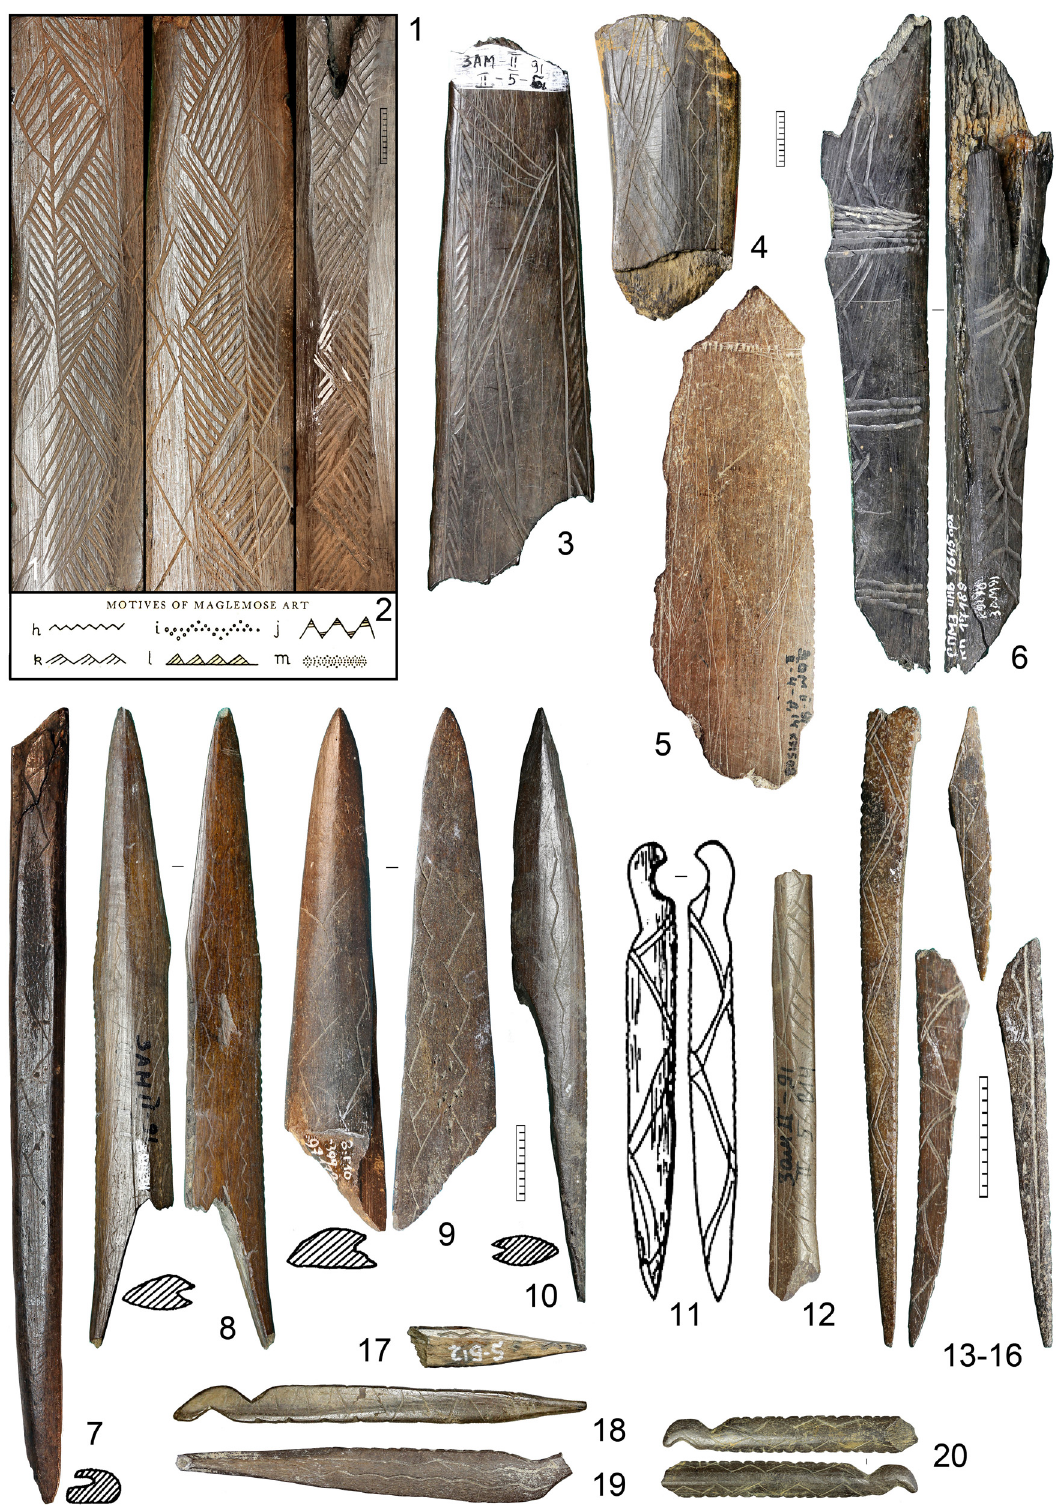
Figure 4: Zamostje 2 ( 1, 3 – 10, 12 – 20 ) , Ozerki 5 ( 11 ) . ( 1, 3 – 6 ) elk rib knives; ( 7 – 10, 13 – 16 ) slotted arrowheads with spikes; ( 11 – 12, 18 – 20 ) miniature ( hair ) pins. Late – Final Mesolithic ( 1, 3, 5, 7 – 20 ) ; unde fi ned ( 4, 6 ) . ( 2 – after Clark, 1936, p. 169; 11 – after Zhilin, 2014, Figure 132: 10 )